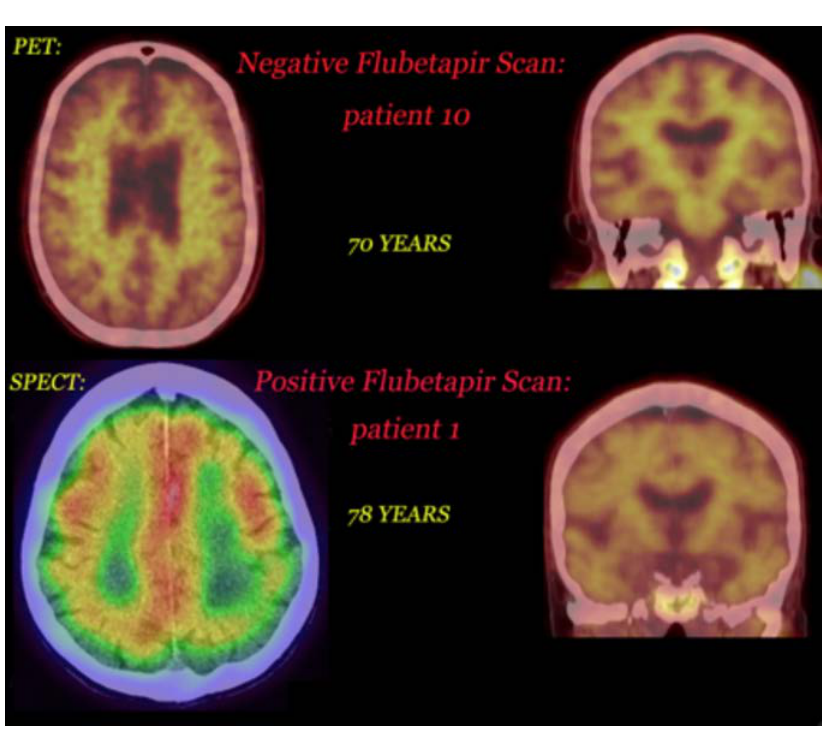
Figure 2. PET images depicting negative results (top) and positive results consistent with Alzheimer’s disease